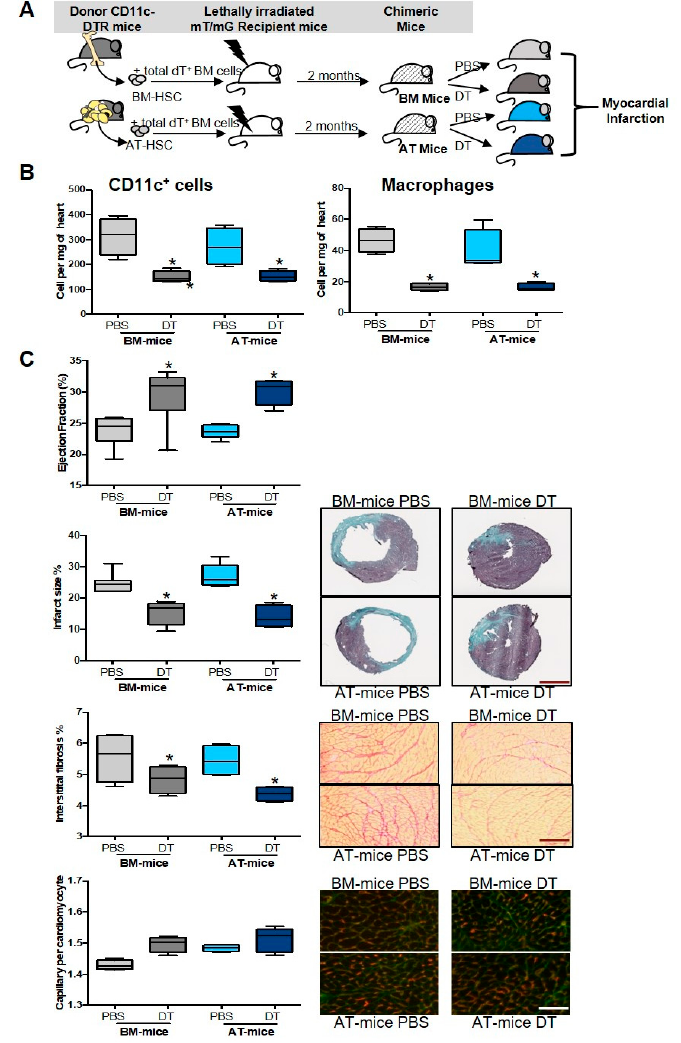
Figure 3. Depletion of adipose tissue-derived CD11c + macrophages improves cardiac remodeling and function after acute MI. ( A ) Schematic representation of experimental procedure: lethally irradiated mT/mG recipient mice were co-injected with hematopoietic stem cells (HSC) sorted from sub-cutaneous adipose tissue (AT) or bone marrow (BM) and total BM cells isolated from CD11c-DTR and mT/mG donor mice, respectively. Eight weeks after reconstitution, chimeric mice were treated with diphtheria toxin (DT) or PBS as control at day 0, 3 and 6 after the ischemic insult. ( B ) Quantification of CD11c + cells and CD11c + macrophages in the heart, 7 days post-MI in BM- and AT-mice (n = 3–4). ( C ) Representative photomicrographs and quantification of ejection fraction, infarction size (scale bar, 2 mm), interstitial fibrosis (scale bar, 10 µ m) and capillary density (scale bar, 10 µ m) in BM and AT-mice treated with or without DT (n = 4–8). Comparisons between groups were performed using Dunn’s multiple comparisons test. * p < 0.05 in DT vs. PBS treated